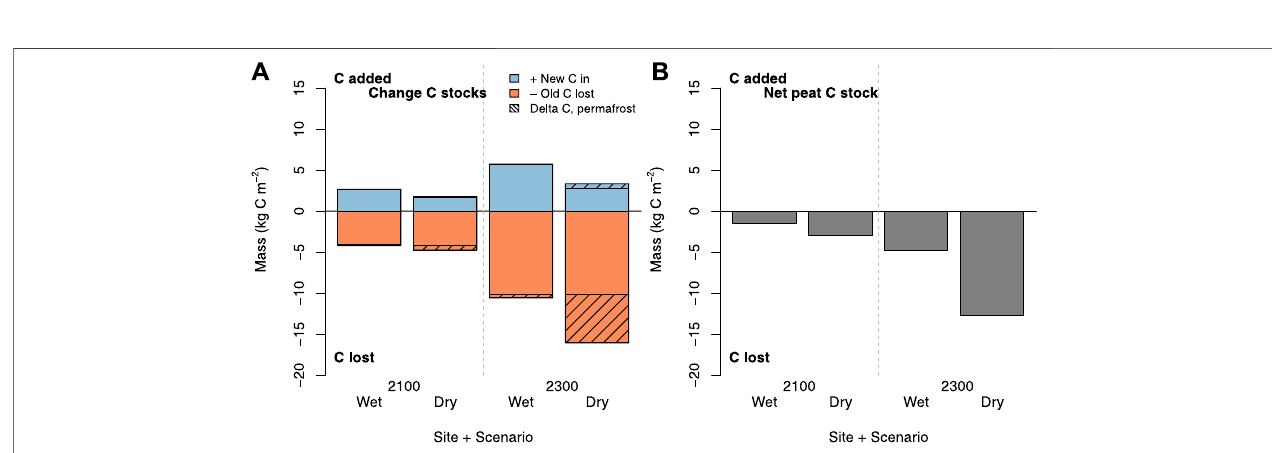
FIGURE 6 | Simpli fi ed peat pro fi le diagrams for changes in C stock for the two landscape scenarios (Wet, Dry) in 2100 CE and 2300 CE relative to 2015 CE. (A) ChangesinCstocks, including newpeatCadded(blue) andold peatClost(orange).Theamountofnewpeatadded oroldpeatlost frompermafrost isindicatedbythe blackdiagonalstripes.NewCadditionsandoldcarbonlossesarede fi nedaspeatdepositedbefore2015(old)orafter2015(new). (B) NetchangeinpeatCstocksinthe two landscape scenarios for the two time periods. All scenarios showed a net peat C loss.